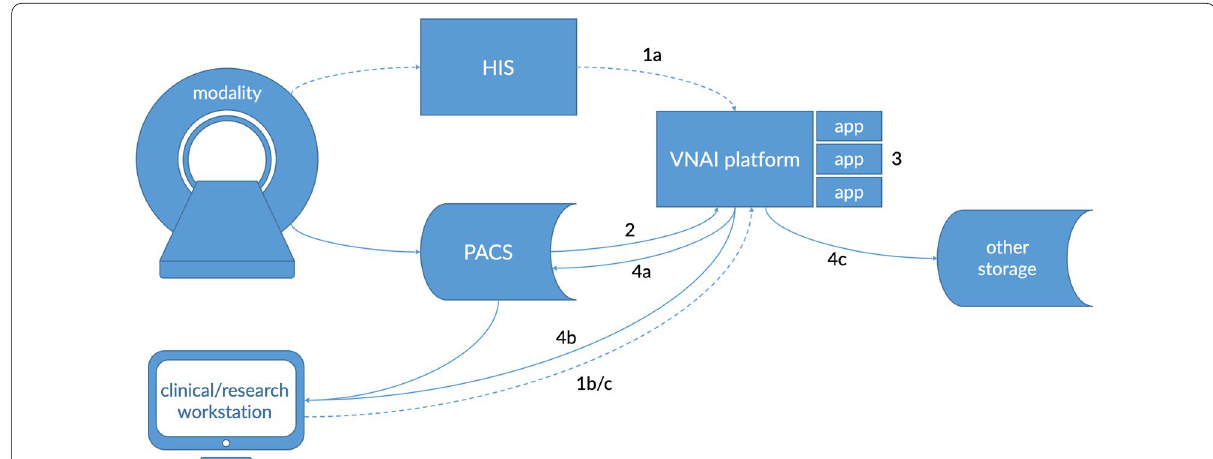
Fig. 1 Interaction with the VNAI platform. Upon completion of image acquisition, the VNAI platform is notified through the hospital information system (HIS) (1a). This, in turn, triggers the VNAI to retrieve relevant images from the PACS system (2) and to run analysis algorithms (3). Subsequently, results are sent back to the PACS system (4a), are available through a dedicated viewing solution (4b) or sent to other forms of storage (4c). The VNAI can also be activated directly by clinical users (1b) or researchers (1c). Numbers refer to the outline of VNAI components in the